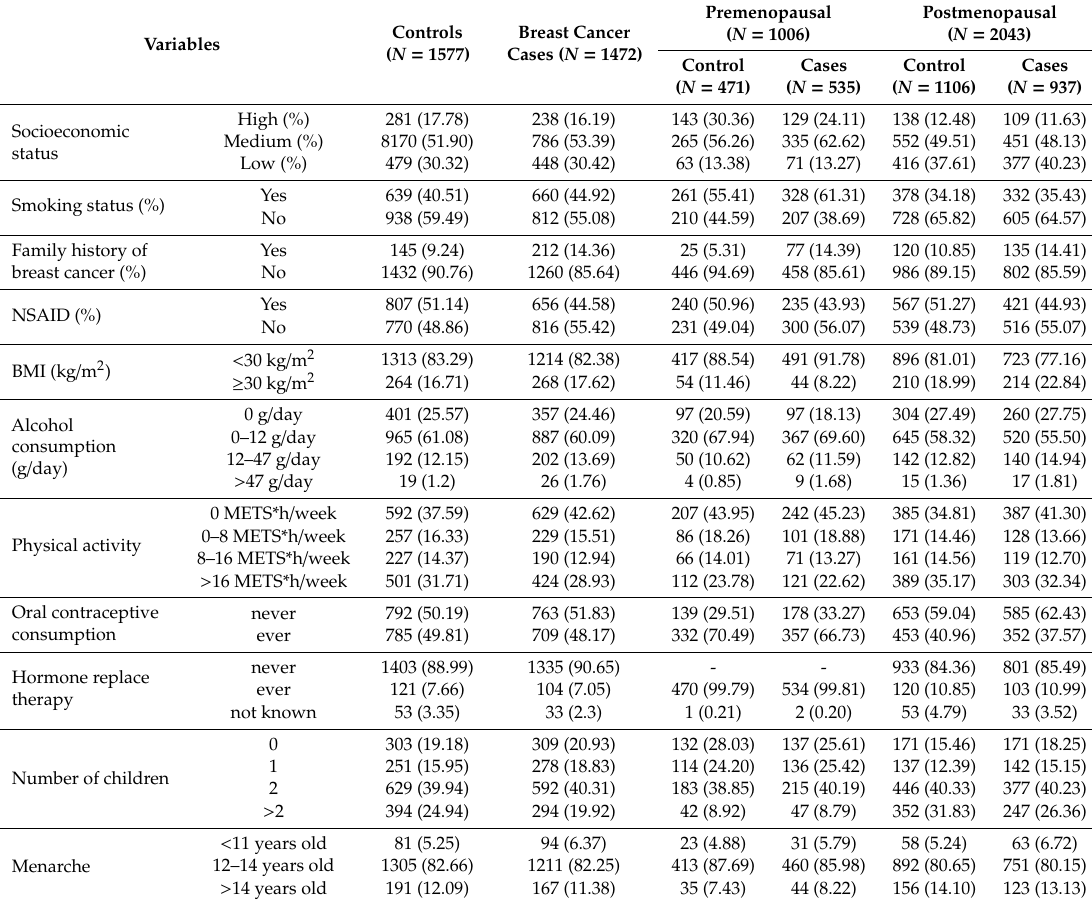
Table 1. Distribution of lifestyle by cases, controls of breast cancer and menopausal